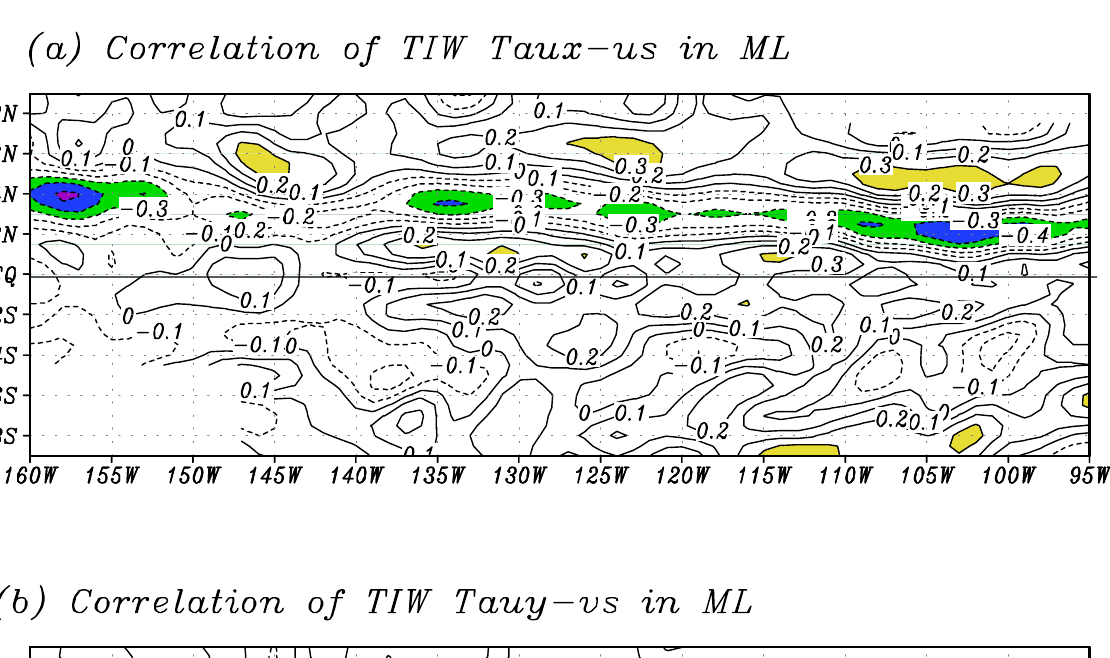
Figure 11. Horizontal distributions of the correlations between the high-pass-filtered wind stress and surface-layer current fields for their ( a ) zonal and ( b ) meridional components, computed using daily data in year 13 from the reference feedback run. The contour interval is